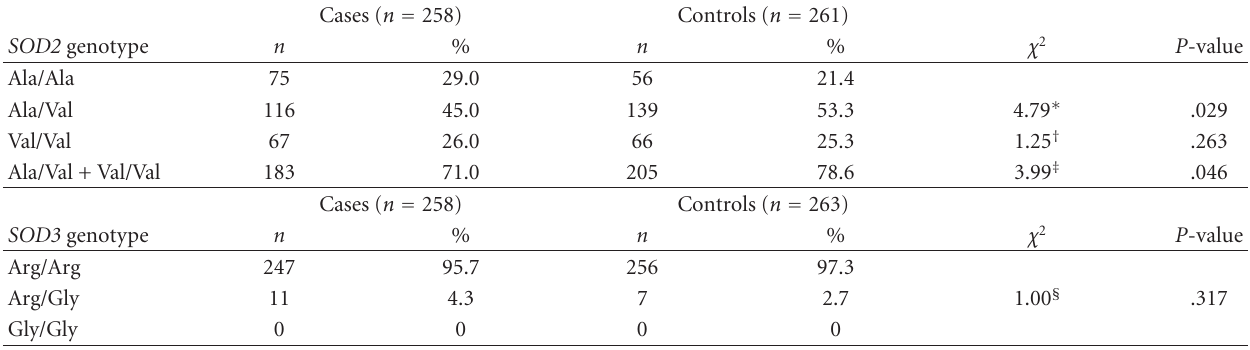
Table 2: Frequencies of SOD2 and SOD3 genotypes in cases and